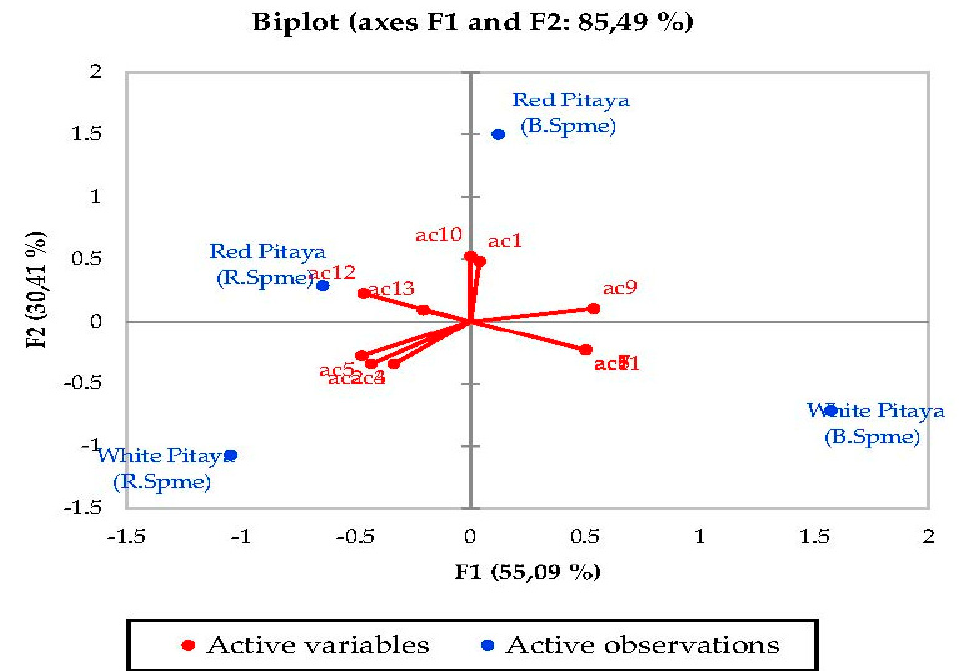
Figure 7. Biplot graph (scores and loading plots) obtained from Principal Component Analysis for acids from volatile compounds in red-white pitaya. ac1: 2-Acetonyl-3-cyano-2,3-dimethylcyclobutane-1-carboxylic acid, ac2: acetic acid, ac3: anhydride acetic acid, ac4: caprylic acid, ac5: Carbamic acid, monoammonium salt, ac6: decanoic acid, ac7: dodecanoic acid, ac8: heptanoic acid, ac9: hexanoic acid, ac10: nonanoic acid, ac11: octanoic acid, ac12: pentadecanoic acid, ac13: tetradecanoic acid.